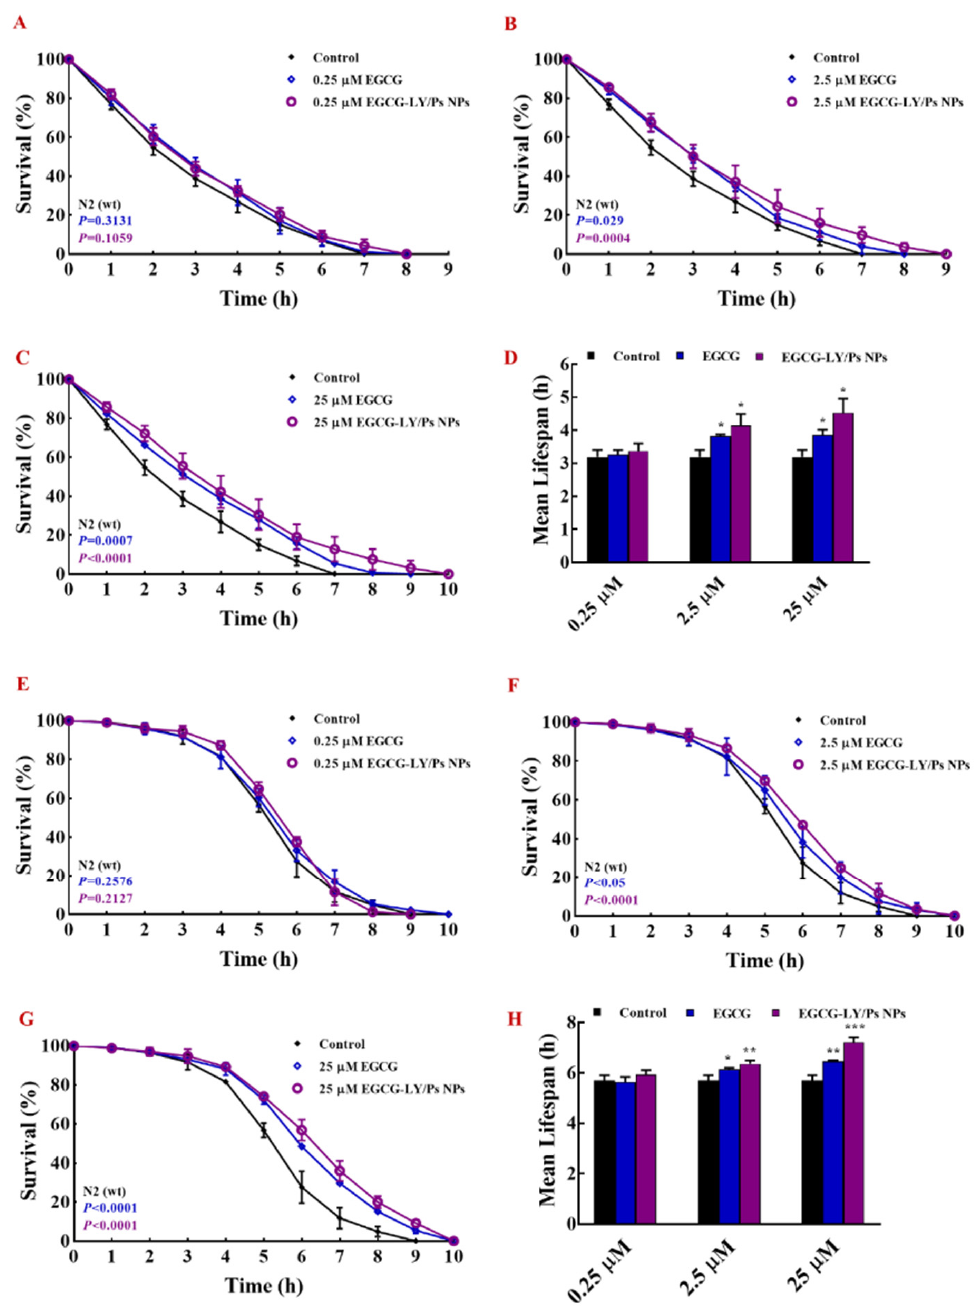
Figure 7. ( A – C ) Survival rates and ( D ) mean lifespan of C. elegans under heat stress. ( E – G ) Survival rates and ( H ) mean lifespan of C. elegans under oxidative stress under different concentrations of free EGCG and EGCG-lysozyme/pectin nanoparticles treatments. At medium concentration of EGCG (2.5 µ M), the survival rate and average lifespan of nematodes in the EGCG-LY/Ps NPs (2.5 µ M) group were significantly higher those in